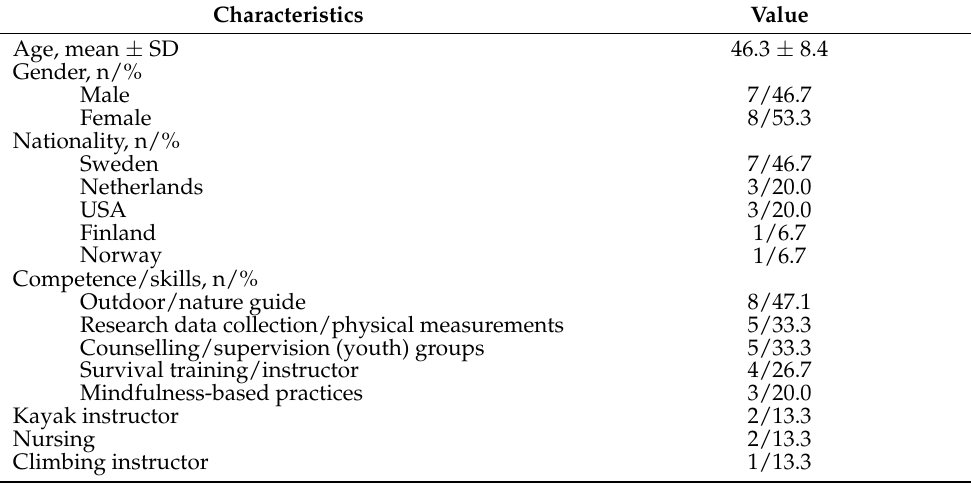
Table 1. Demographic characteristics and competences of facilitators ( n =